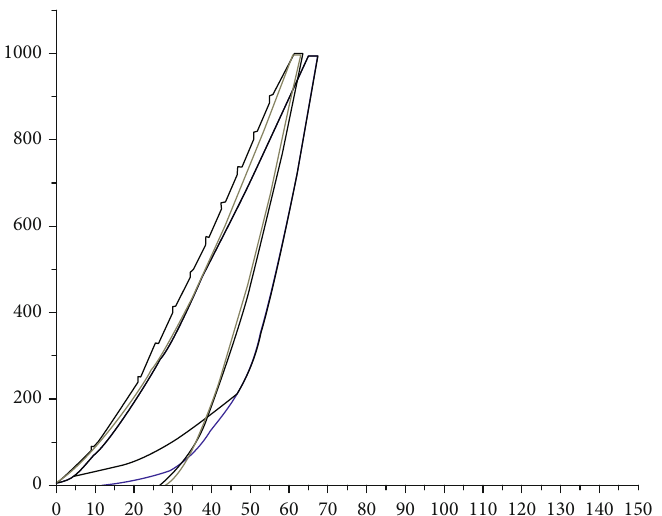
Figure 2: Load vs. de fl ection curve of DLC thin fi lm measured using nanoindentation.